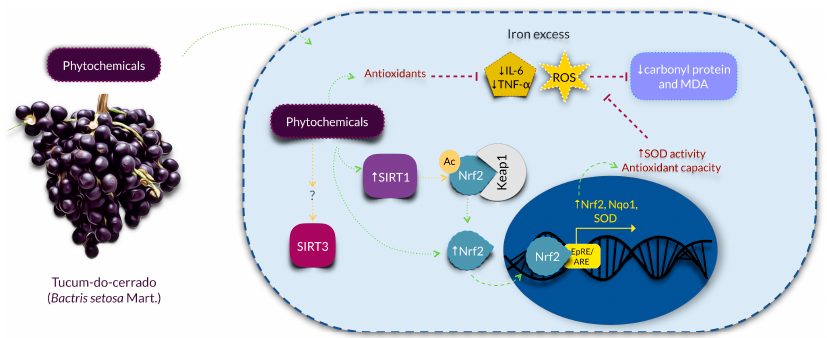
Figure 7. Proposed mechanism of action of the phytochemical compounds of tucum-do-cerrado in the prevention of aging, by the upregulation SIRT1-Nrf2 pathway, attenuating oxidative stress and inflammation, in the liver. Tucum-do-cerrado is a source of phytochemical compounds, which might enter the cells and act directly as anti-inflammatory molecules and/or reducing agents, promoting the upregulation of the longevity protein SIRT1. The upregulation of SIRT1 may causes the deacetylation of Nrf2, making it stable and active. Nrf2 migrates to the nucleus and induces antioxidant enzymes and its own transcription, rising the cell antioxidant capacity. Then, by reduction of the ROS generation, the oxidative damages to protein and lipids are lowered and the inflammatory response is attenuated. The effect of tucum-do-cerrado in SIRT3 remains to be elucidated. Ac: acetylation; IL-6: interleukin-6; Keap1: Kelch-like ECH-associated protein 1; MDA: malondialdehyde; Nqo1: NAD(P)H